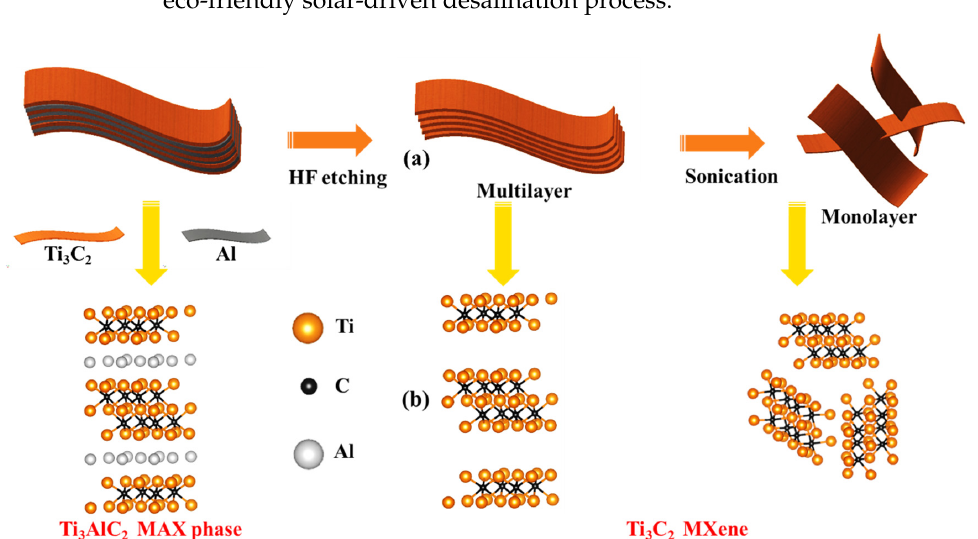
Figure 3. ( a ) Schematic representation of HF etching of Ti 3 AlC 2 MAX phase and its transformation into Ti 3 C 2 MXene multilayer and monolayer, and ( b ) corresponding chemical bondings in the Ti 3 AlC 2 MAX phase and Ti 3 C 2 MXene before and after etching.